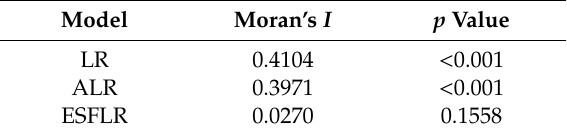
Figure 5. The ROC curves: ( a ) the LR model; ( b ) the ALR model; ( c ) the ESFLR model. Table 9. Moran’s I values of the residuals in the three regression